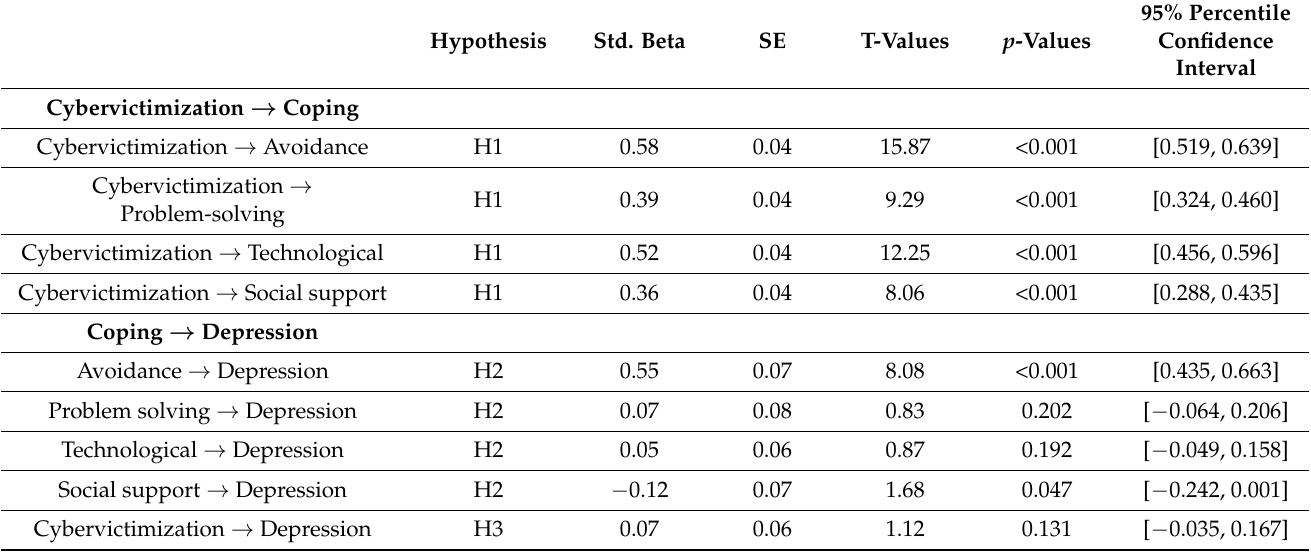
Table 3. Results of direct effect